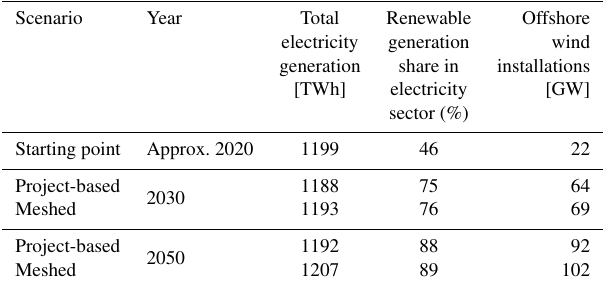
Table 2. Aggregate North Sea region results for the project- based and meshed offshore grid scenarios; data from Koivisto et al. (2020).